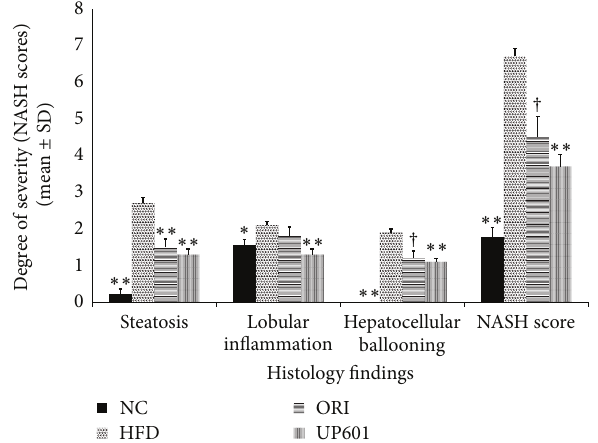
Figure 7: Nonalcoholic steatohepatitis scores for mice in the HFD study group treated with Orlistat and UP601 at doses of 1.3g/kg. ∗∗ 𝑃 ≤ 0.0001 ; † 𝑃 ≤ 0.001 ; ∗ 𝑃 ≤ 0.05 .